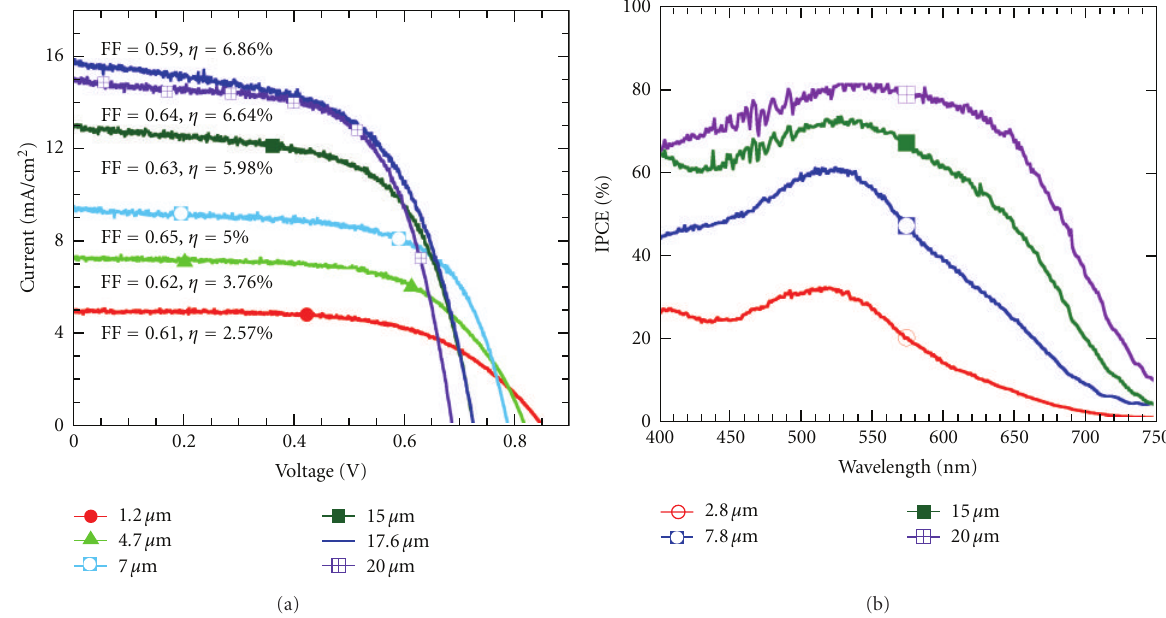
Figure 20: (a) Current-voltage characteristics of DSSCs fabricated using transparent nanotube array films of various lengths. The pore size of the 1.2 μ m film was 58 nm, while it was 95 nm for the rest of the films. The 20 μ m long nanotubes were fabricated from a 12 μ m thick Ti film. (b) The IPCE spectra of DSSCs fabricated using transparent nanotube array films of various lengths. Reprinted with permission from